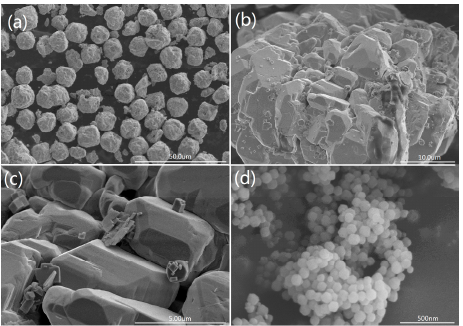
Figure 3. SEM images of ( a ) pure BiFeO 3 ; ( b , c ) the magnification of pure BiFeO 3 ; and ( d ) pure MOF.